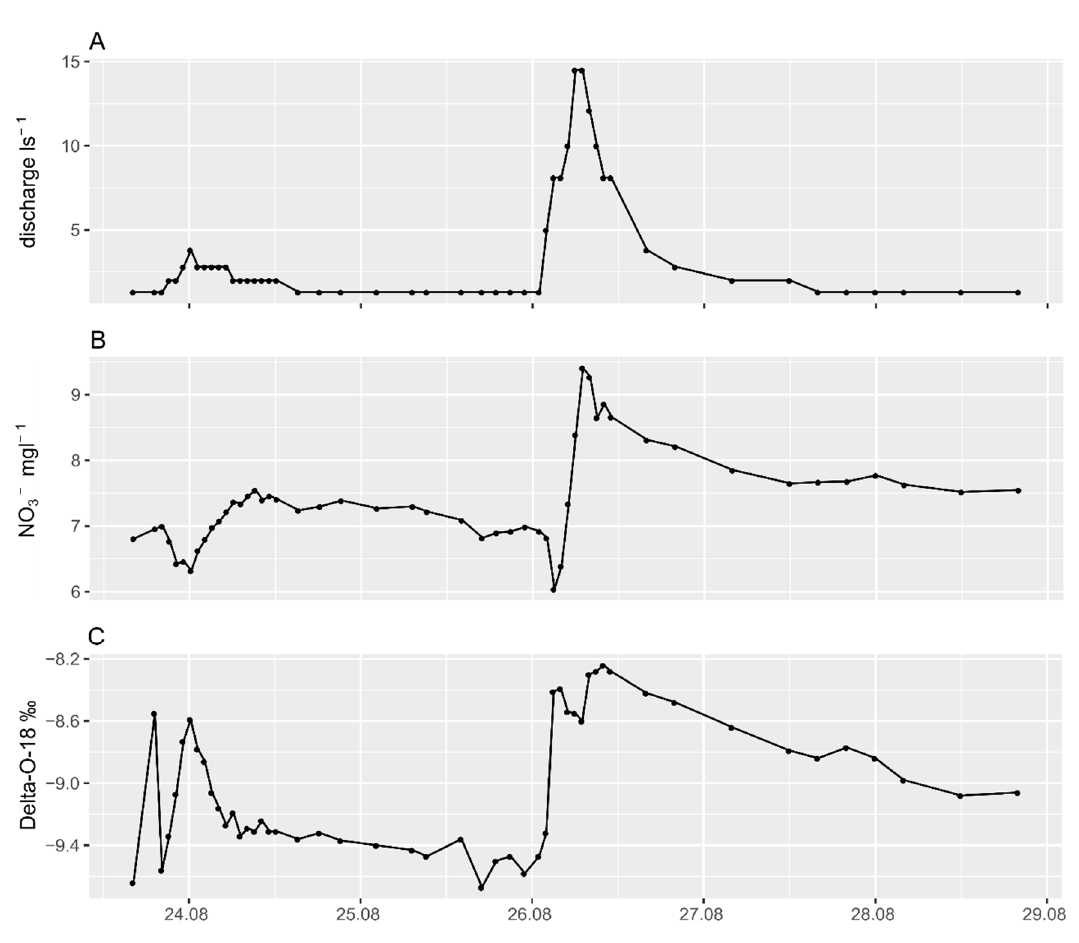
Figure 6. ( A ) Discharge, ( B ) NO 3 − concentrations, and ( C ) δ 18 O at the gauging station 551 during a rainfall event in the year 2012.